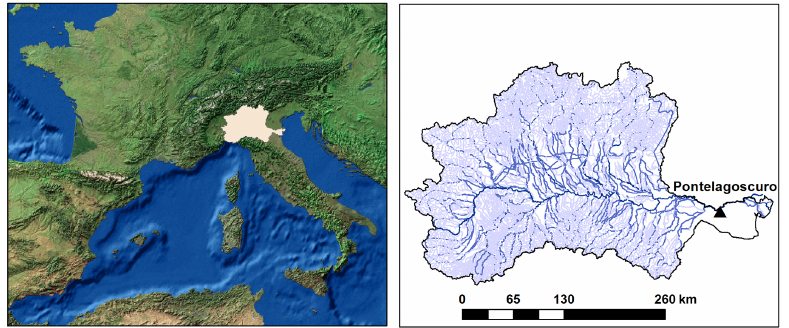
Figure 1. Po River Basin. Location (left), drainage network and closure section at Pontelagoscuro (right).